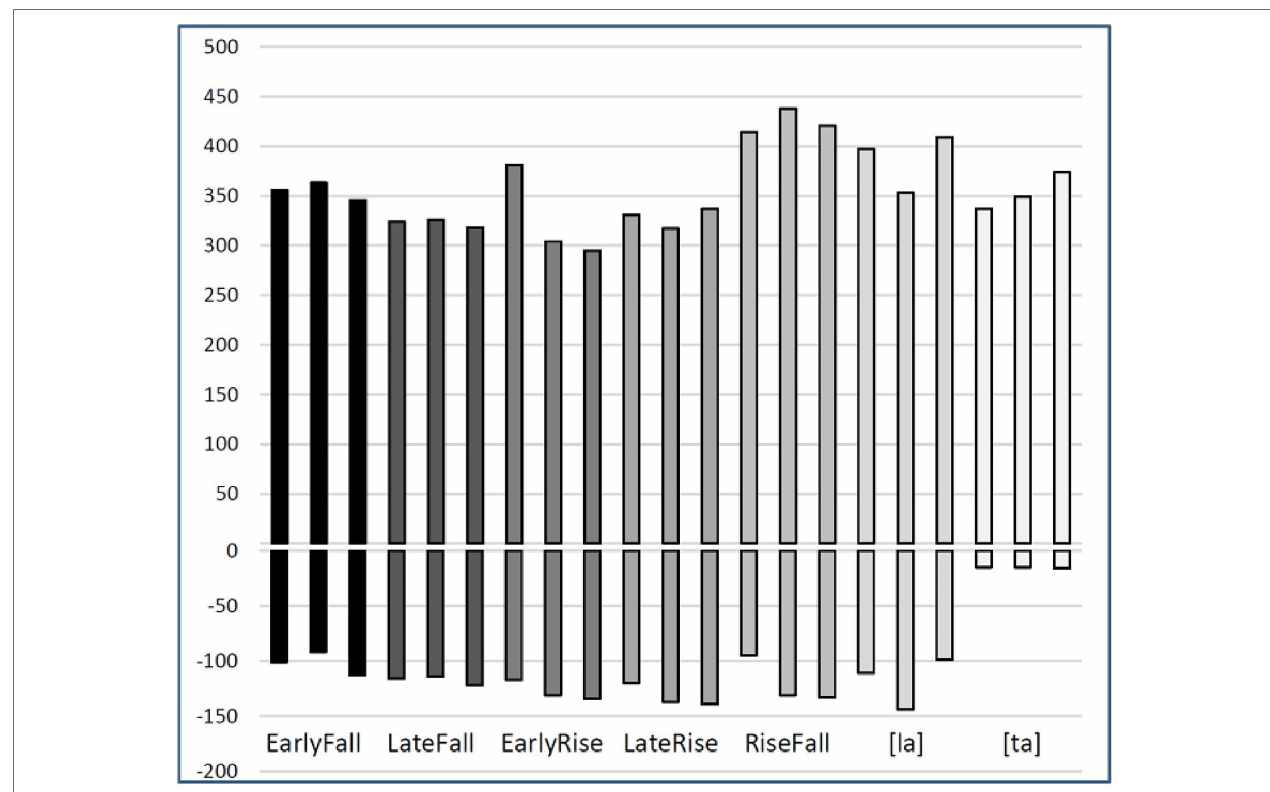
FIGURE 6 | Durations of onset [l] (negative bars) and rhyme [a] (positive bars) of the 27 stimuli in the experiment. For [ta], the negative bars give the positive VOTs. The value for the onset in [ta] is the burst and friction of the released